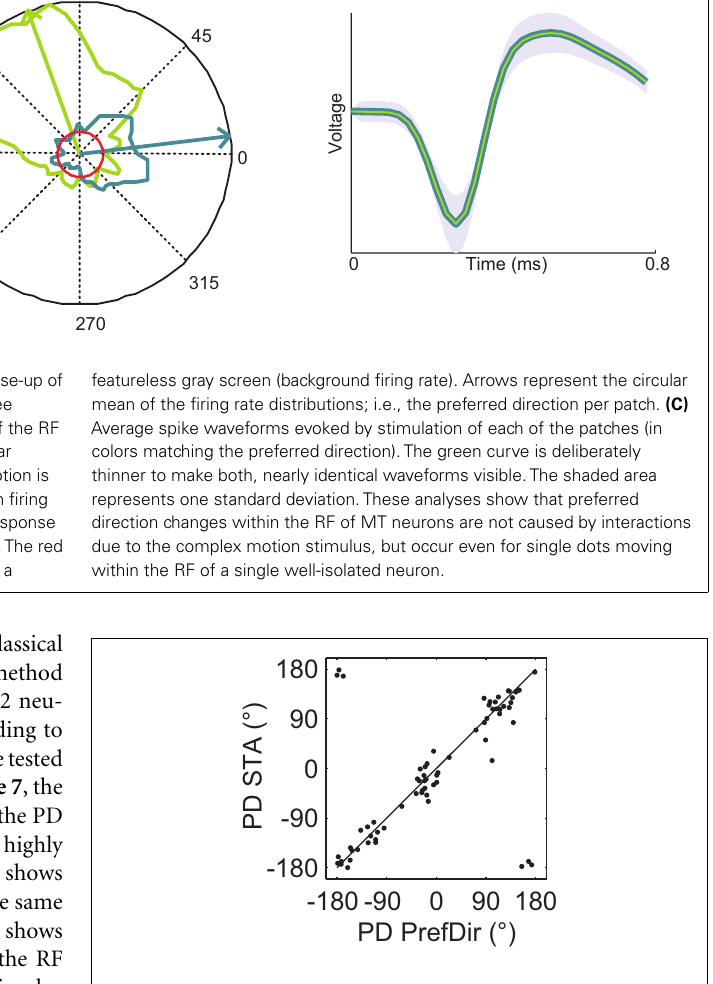
FIGURE 7 |Validation of preferred direction estimates. Each point represents the preferred direction in one location for those neurons where the PD was mapped using a single moving dot (PrefDir; horizontal axis) as well as the full-field motion stimulus (BMDots; vertical axis). Data are from 70 patches recorded in 22 neurons. Note that the 6 “outliers” are merely the result of presenting polar data on a Cartesian plot.The circular correlation between the two estimates was 0.9 ( p < 0.001).This figure shows that the whole-field BMDots motion stimulus and its reverse correlation analysis result in preferred direction estimates that match those obtained with a classical single dot mapping